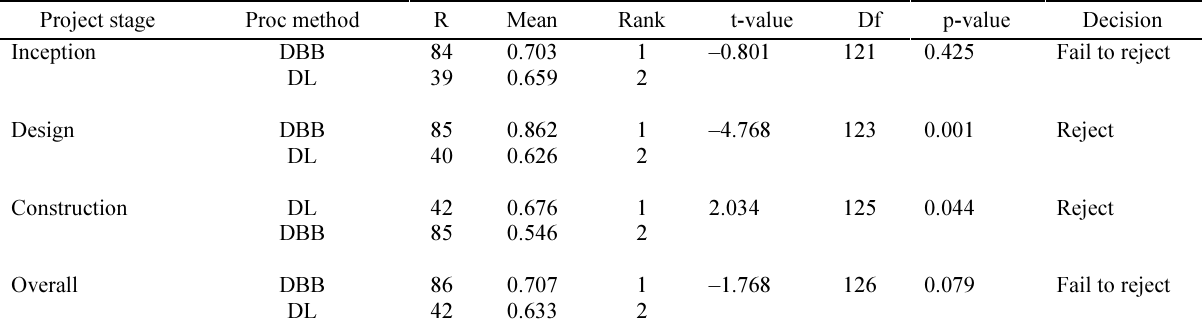
Table 7. Ranking of the levels of project inception, design, construction and overall planning in projects procured by design-bid- build and direct labour